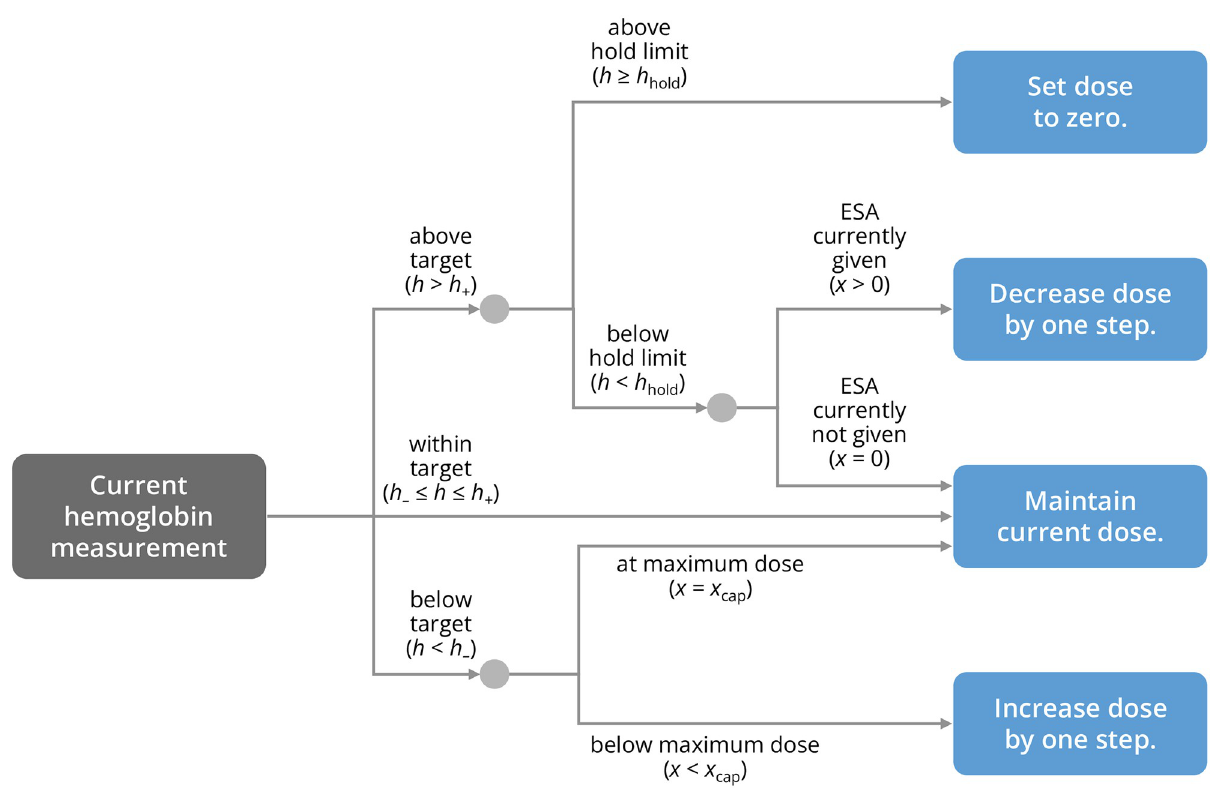
Fig 2. Simplified ESA dosing scheme. Decision tree used in the biomedical model that represents the prototypical features ESA dosing schemes based on a patient’s current hemoglobin